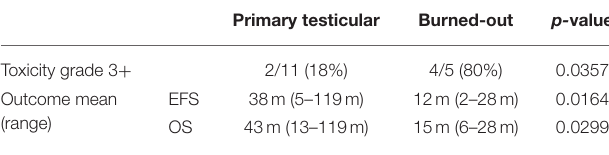
TABLE 2 | Toxicity and outcome results.